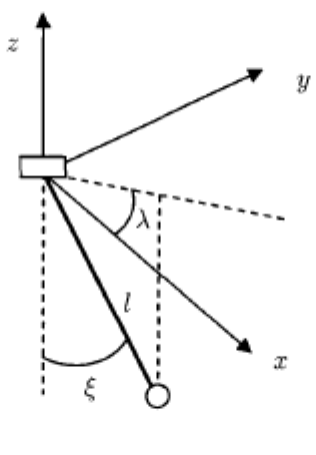
Figure 2: owe drive axle simplified model of the